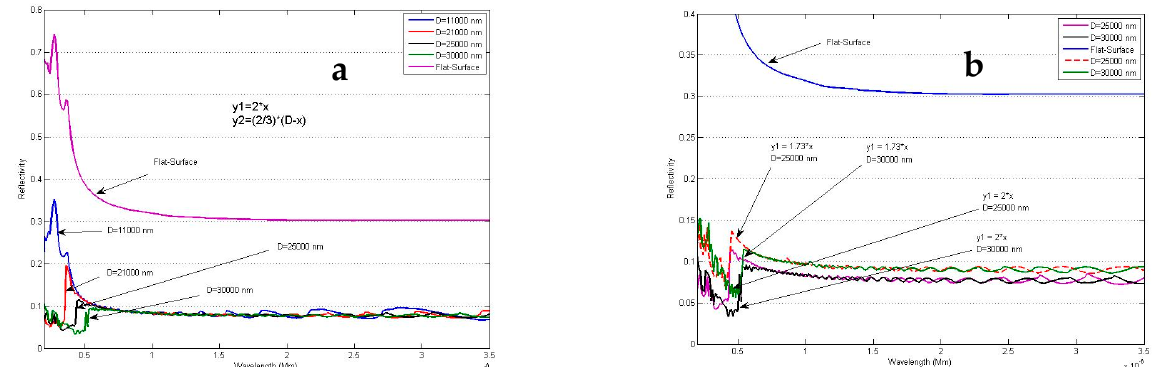
Figure 4. ( a ) Experimental triangular microstructures on Si surface [9], ( b ) Schemes of the micro- structure of interest for simulation with programming code, ( c ) Simulation result for microstruc- tures with a periodicity of 11, 21, 25 and 30 μ m. The height of the structures for a typical sample with a periodicity of 30 μ m is set to be ~13 μ m.